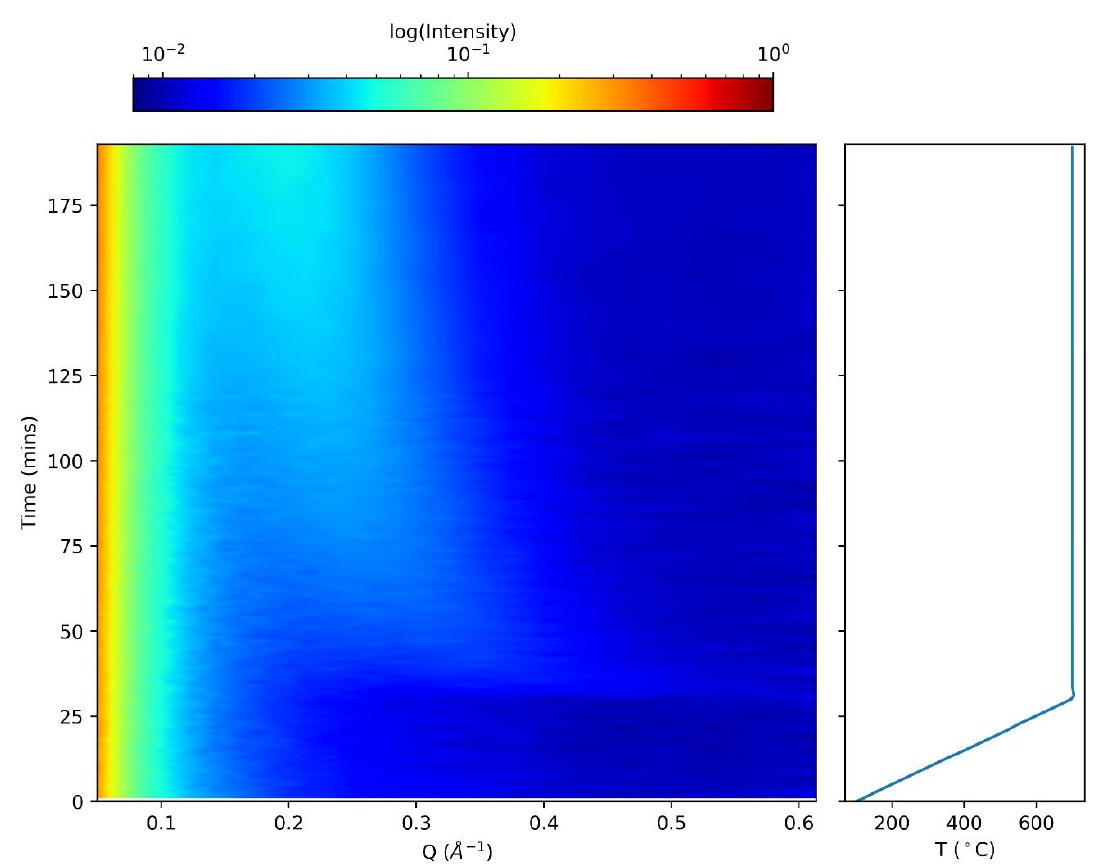
Figure 10. The SANS data processed over the time course of an experiment showing the rapid precipitation in a novel alloy under heating. On the left side, each slice along Q is a traditional Intensity vs. Q curve in SANS (the intensity is in cm − 1 ). On the right side is the temperature of the sample environment over time, also recorded as the event mode data.